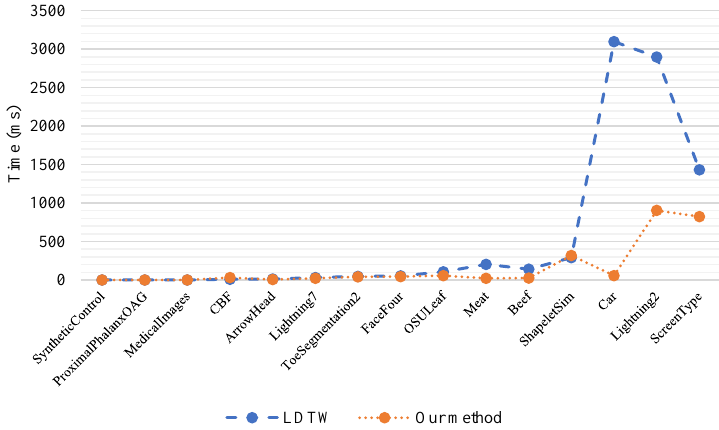
Figure 10. Comparisons between LDTW and our method in terms of time costs.